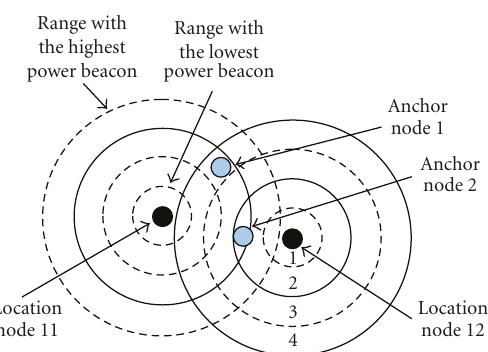
Figure 2: LocMAC base operation principle: relative locations of anchor and location nodes and radio ranges with di ff erent trans- mission